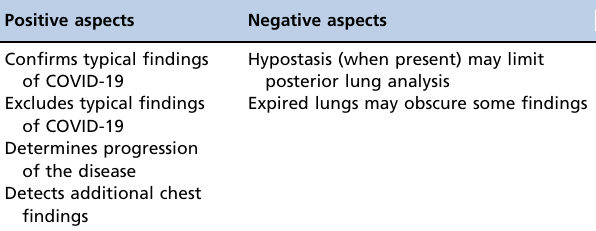
Table 2 - Main positive and negative aspects of our